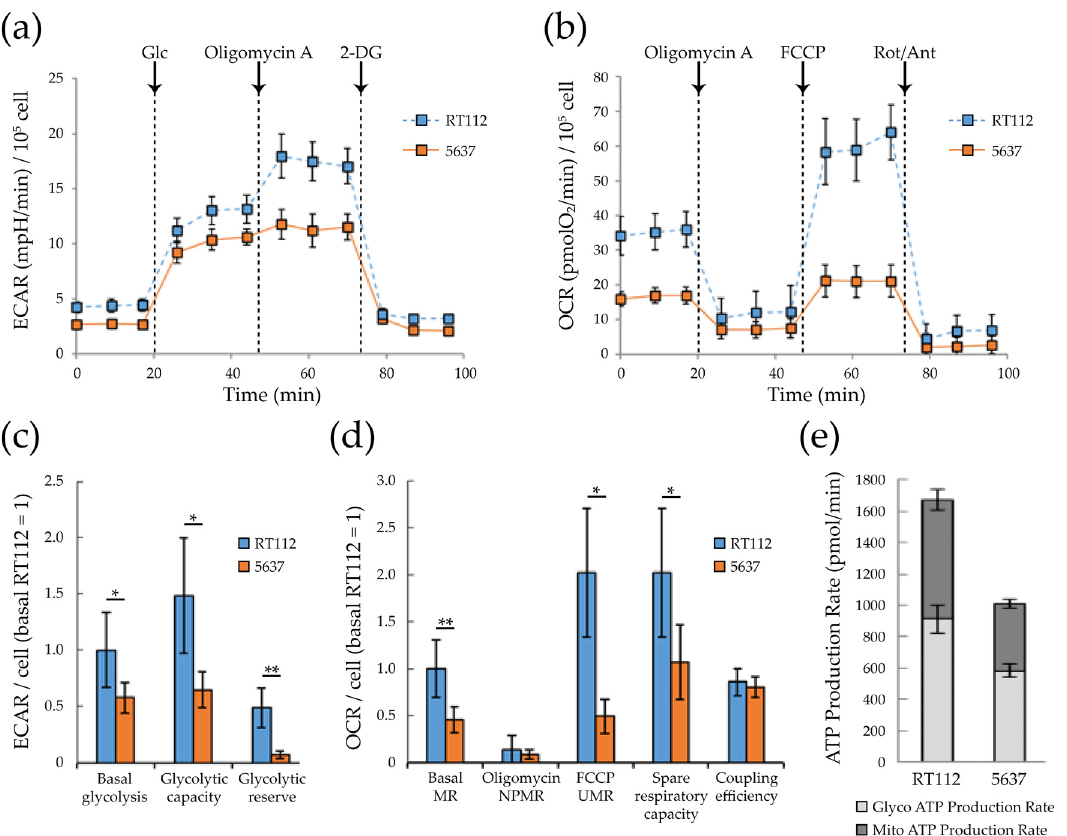
Figure 3. Glycolysis and respiratory bioenergetics of RT112 and 5637 cells. ( a ) Representative ExtraCellular Acidification Rate (ECAR) profile of monolayer cells subjected to XF Glycolysis Stress Test with XF24 Agilent Seahorse under sequential injections of 10 mM glucose, 0.25 µM oligomycin A and 50 mM 2-deoxy-glucose ( b ) Representative Oxygen Consumption Rate (OCR) profile of monolayer cells subjected to XF Mito Stress Test with XF24 Agilent Seahorse under sequential injections of